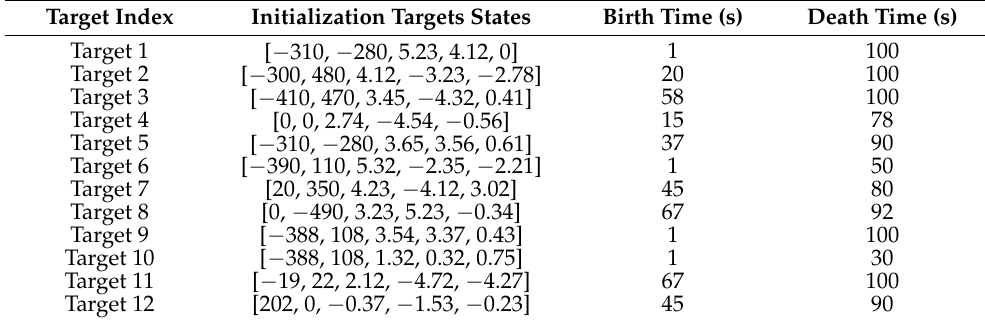
Table 1. The initialization of true targets, along with their birth time and death